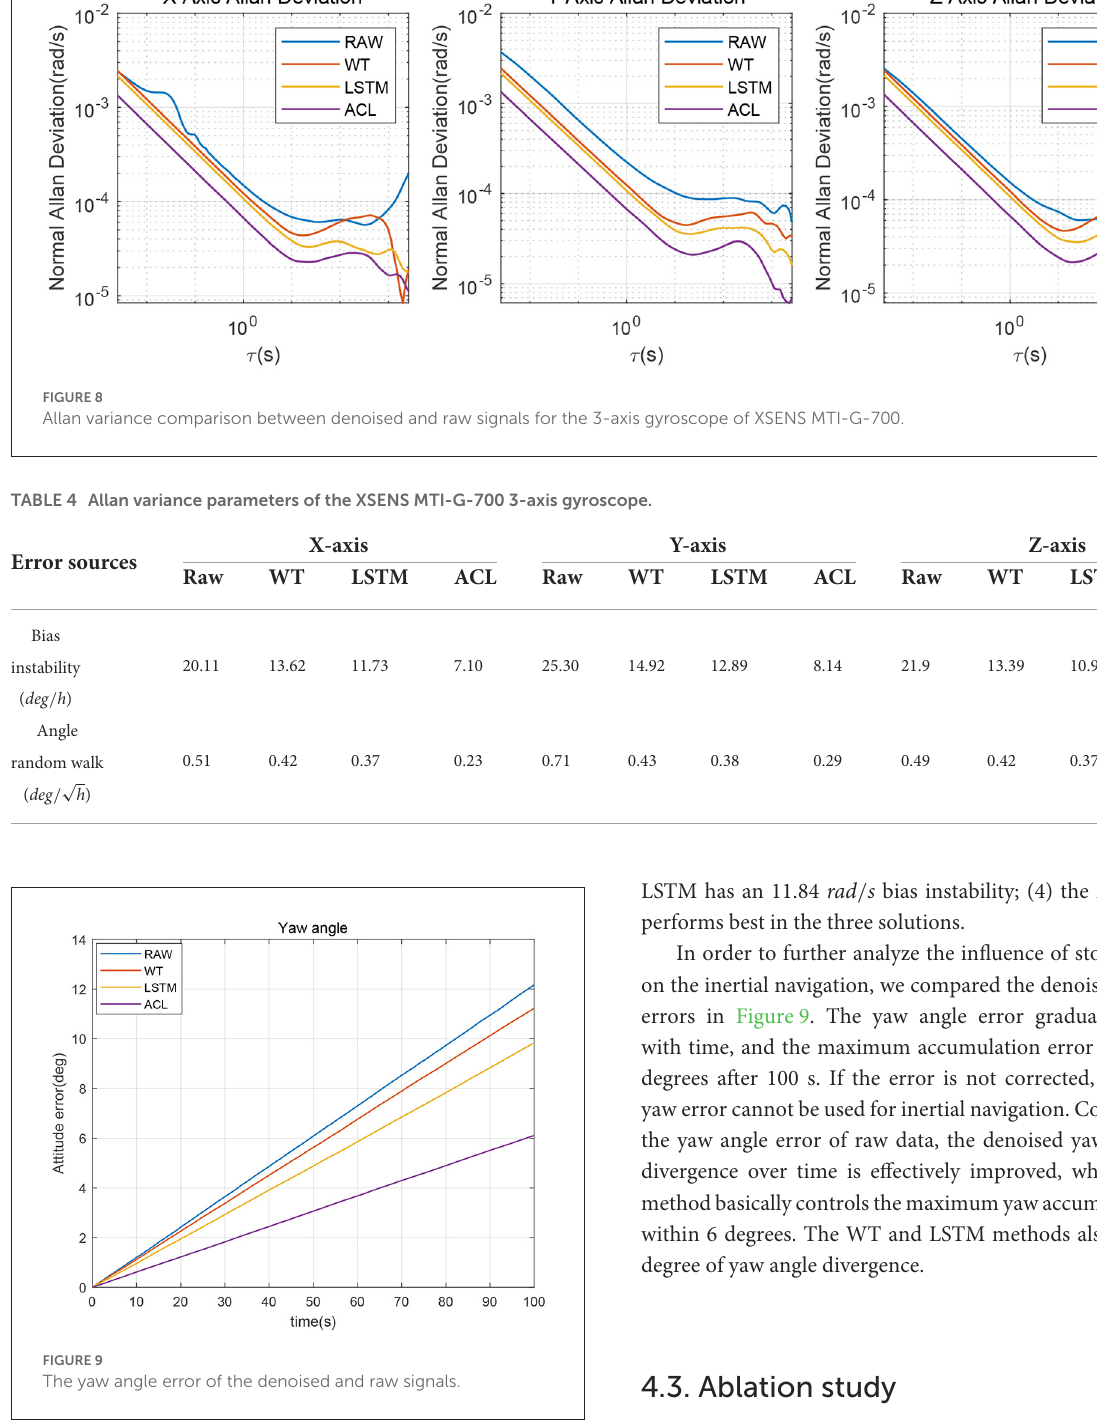
bias instability, i.e., 22.4 deg / h ; (2) the WT is better than the raw data, and the bias instability is reduced to 13.98 rad / s ; (3)